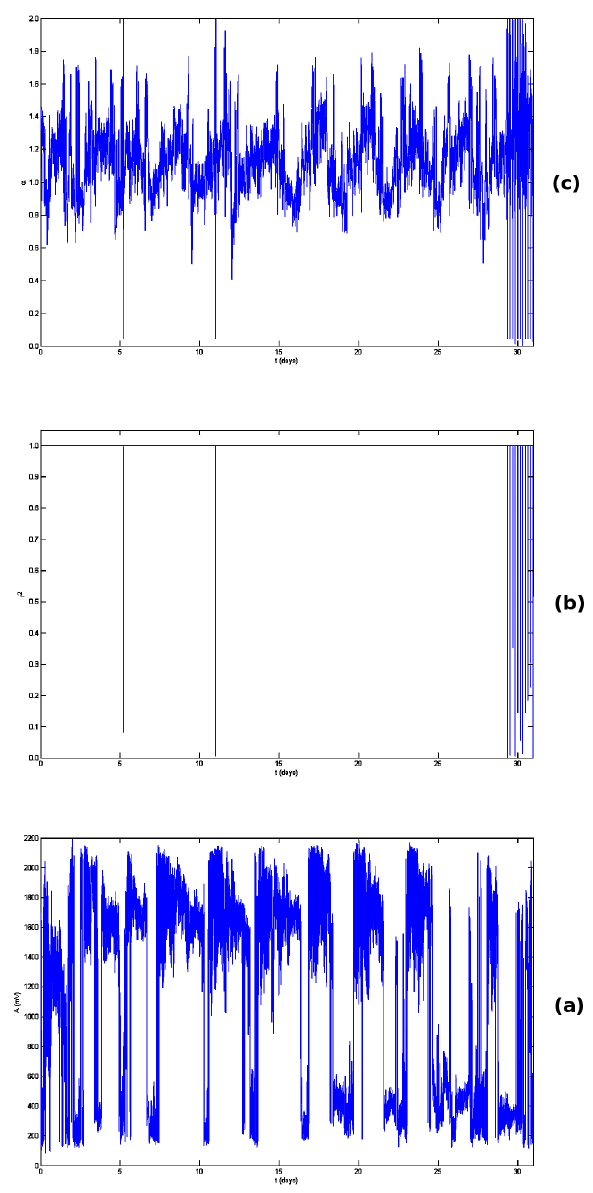
Figure 3. Results of DFA. From bottom to top: ( a ) The EM time series; ( b ) The Spearman’s correlation coe ffi cient of the goodness of the linear fit of F ( n ) versus n in every 1024-sample window; ( c ) The scaling exponent α (DFA slope). Horizontal axis is in days from the beginning of measurements (2018 / 10 / 26). The measurement sampling rate is 1 s − 1